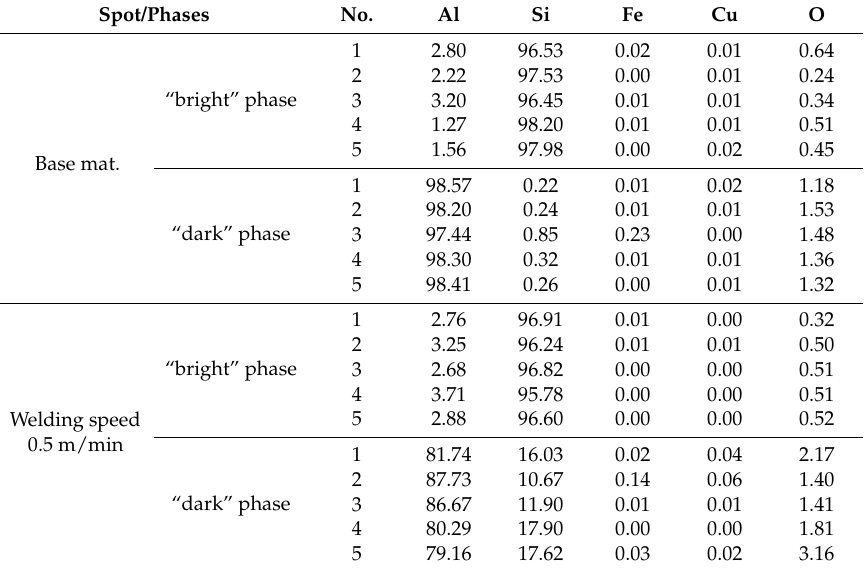
Welding speed 10 m/min